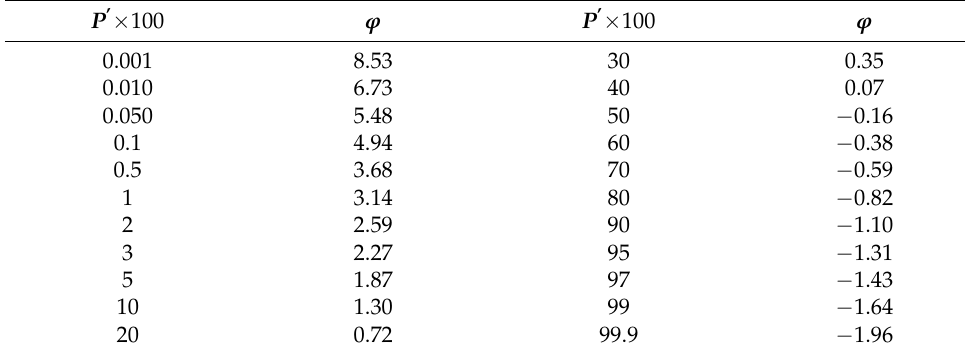
Table 1. Coefficient of deviation mean for Gumbel